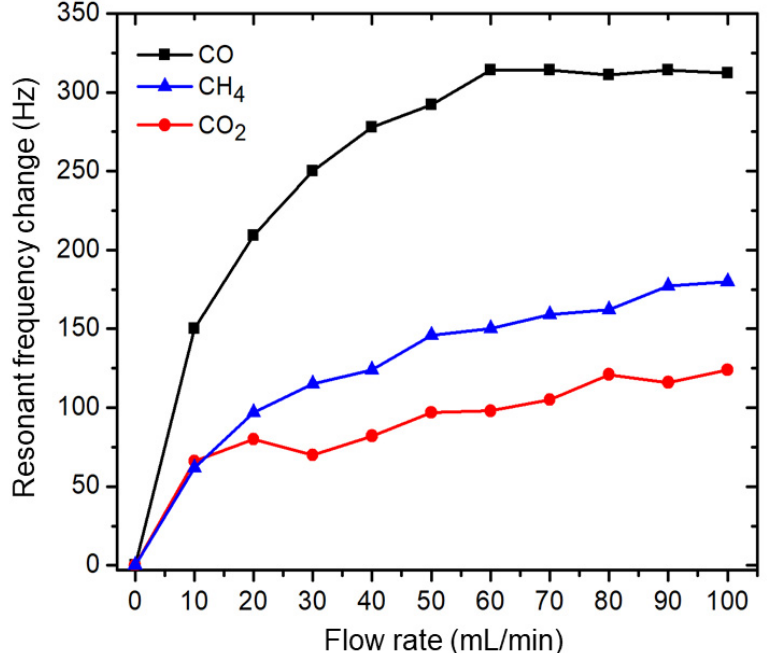
Figure 9. Resonant frequency change of Al-doped ZnO nanorod-coated MC upon exposure to CO, CO 2 , and CH 4 with flow rates of 10–100 mL / CO 2 , and CH 4 with flow rates of 10–100 mL/min.